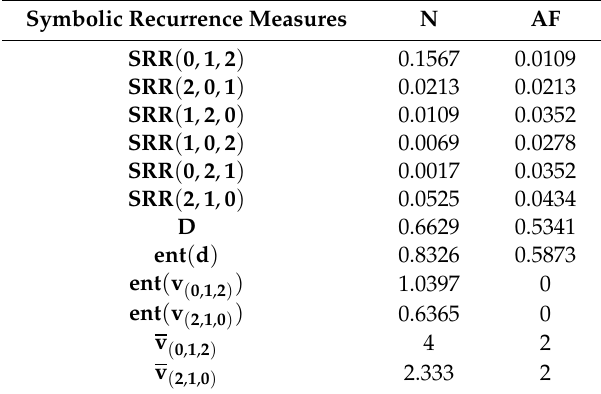
Table A1. Symbolic recurrence measures obtained from 50 RR interval data in normal sinus (N) and atrial fibrillation (AF) patients from Figure 3. Symbolic Recurrence Measures